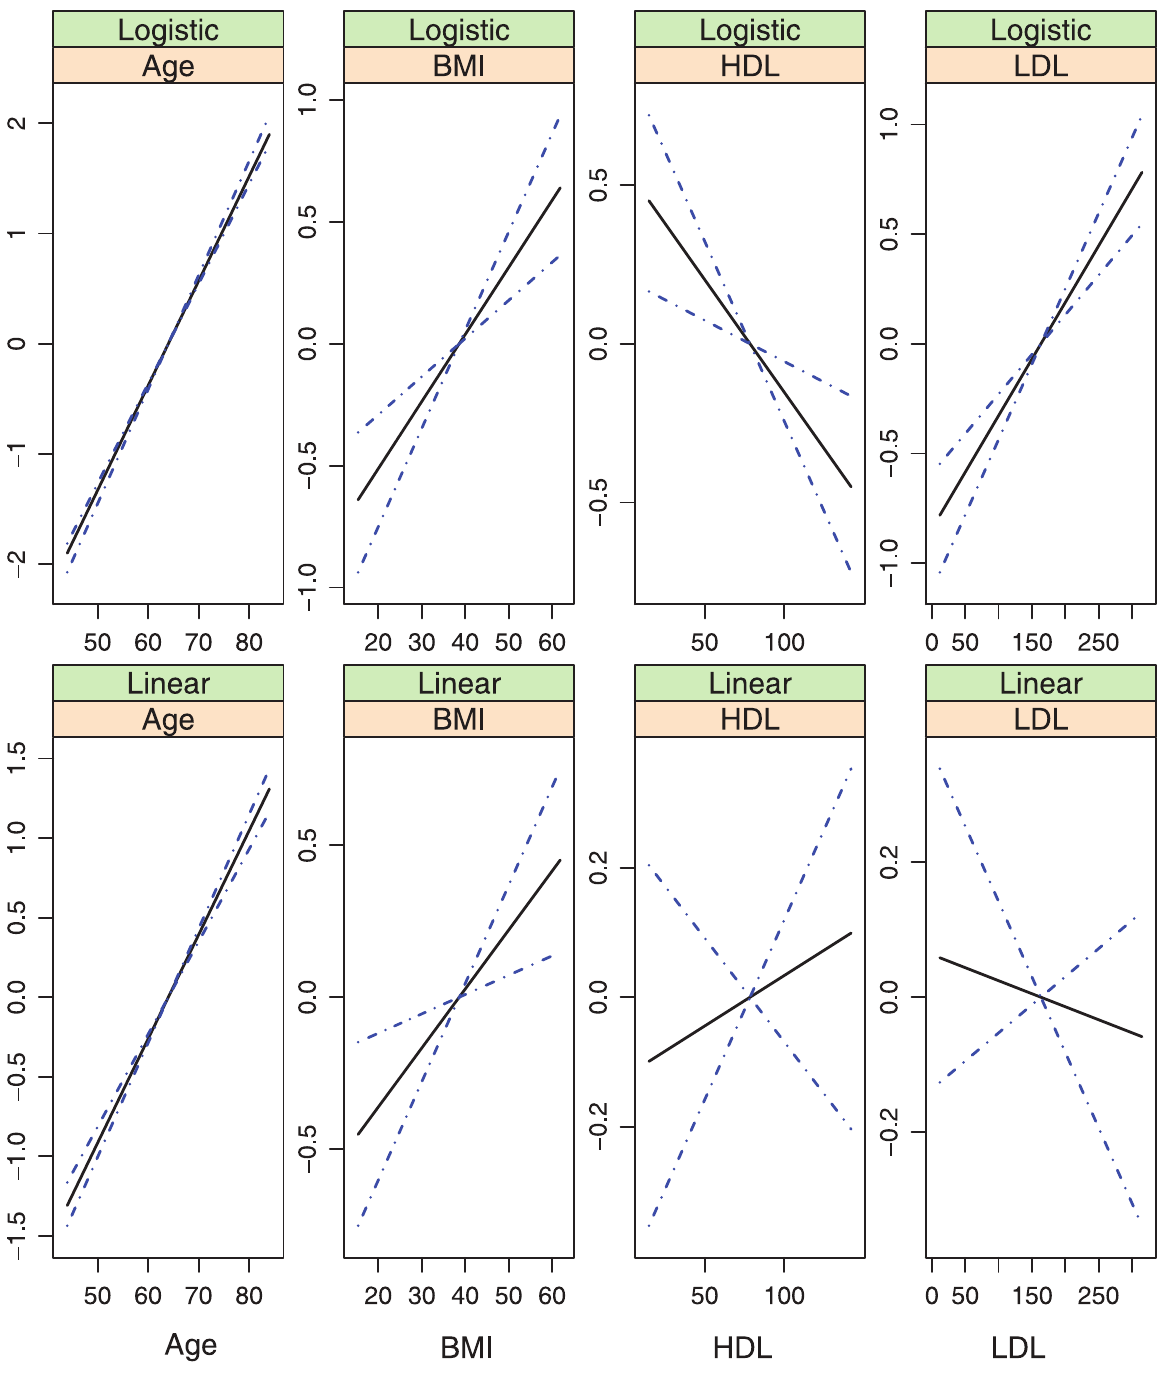
Figure 4. Model (ii.1): estimated covariate effects for age, BMI, HDL, and LDL. The solid line is the estimate. The dash-dotted lines are the point-wise 95% confidence intervals. The y-axis is the value of the function.